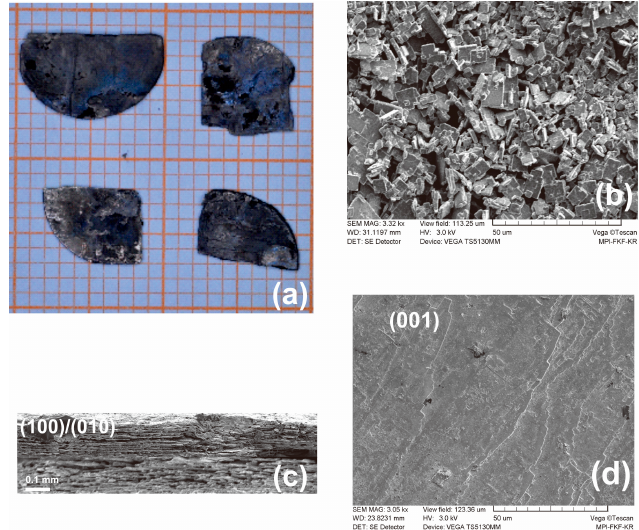
Figure 5. ( a ) As-grown ion-exchanged (Li 1 − x Fe x )OHFeSe single crystals; ( b ) [(Li 1 − x Fe x )OH]( Fe 1 − y Li y )]Se by-products; ( c ) the (100)/(010) plane showing cracked layers along the (001) after ion exchange process; ( d ) the as-cleaned (001) surface after ion exchange process [53]. Reprinted with permission from IOP. All rights reserved. permission from IOP. All rights